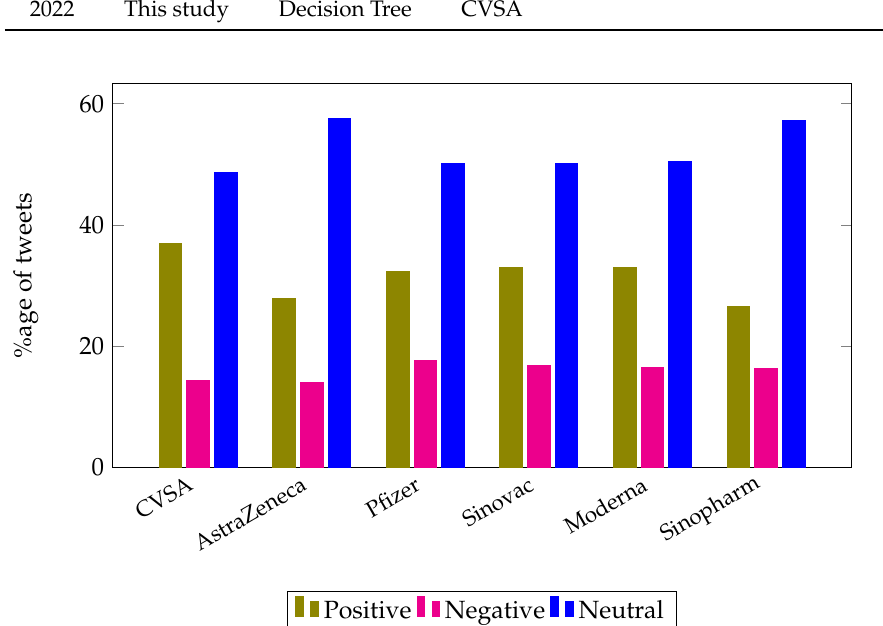
Figure 15. Percentage of positive, negative and neutral tweets in datasets used for this